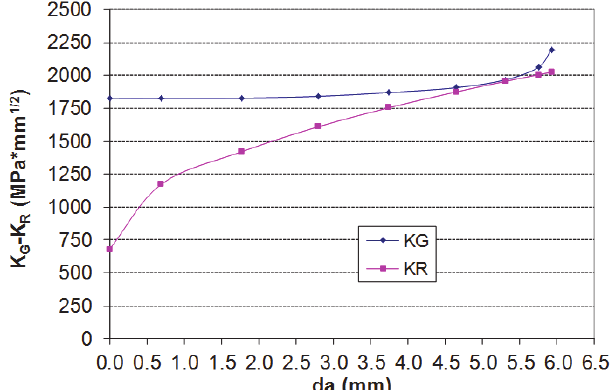
Figure 8: R-G stability diagram with the G -curve corresponding to a load of 143 MPa.